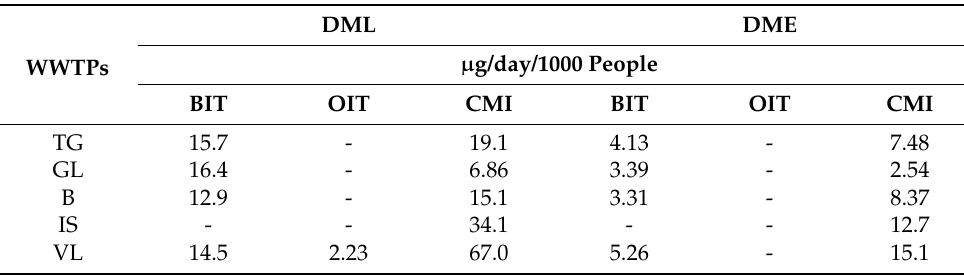
Table 1. Daily consumption levels and environmental emission of the 4 biocide compounds ( µ g/day/1000